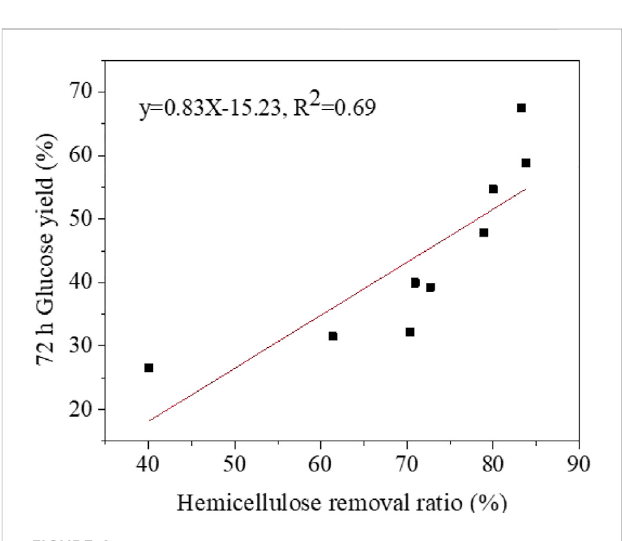
FIGURE 4 The relationship between hemicellulose removal and 72 h glucose yield of pretreated